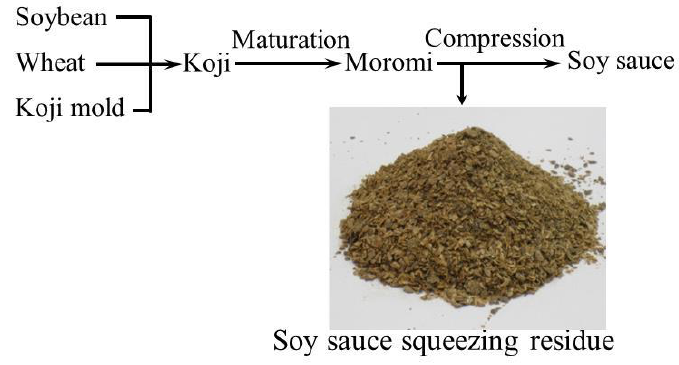
Figure 1. Production of soy sauce squeezing residue (SSSR).